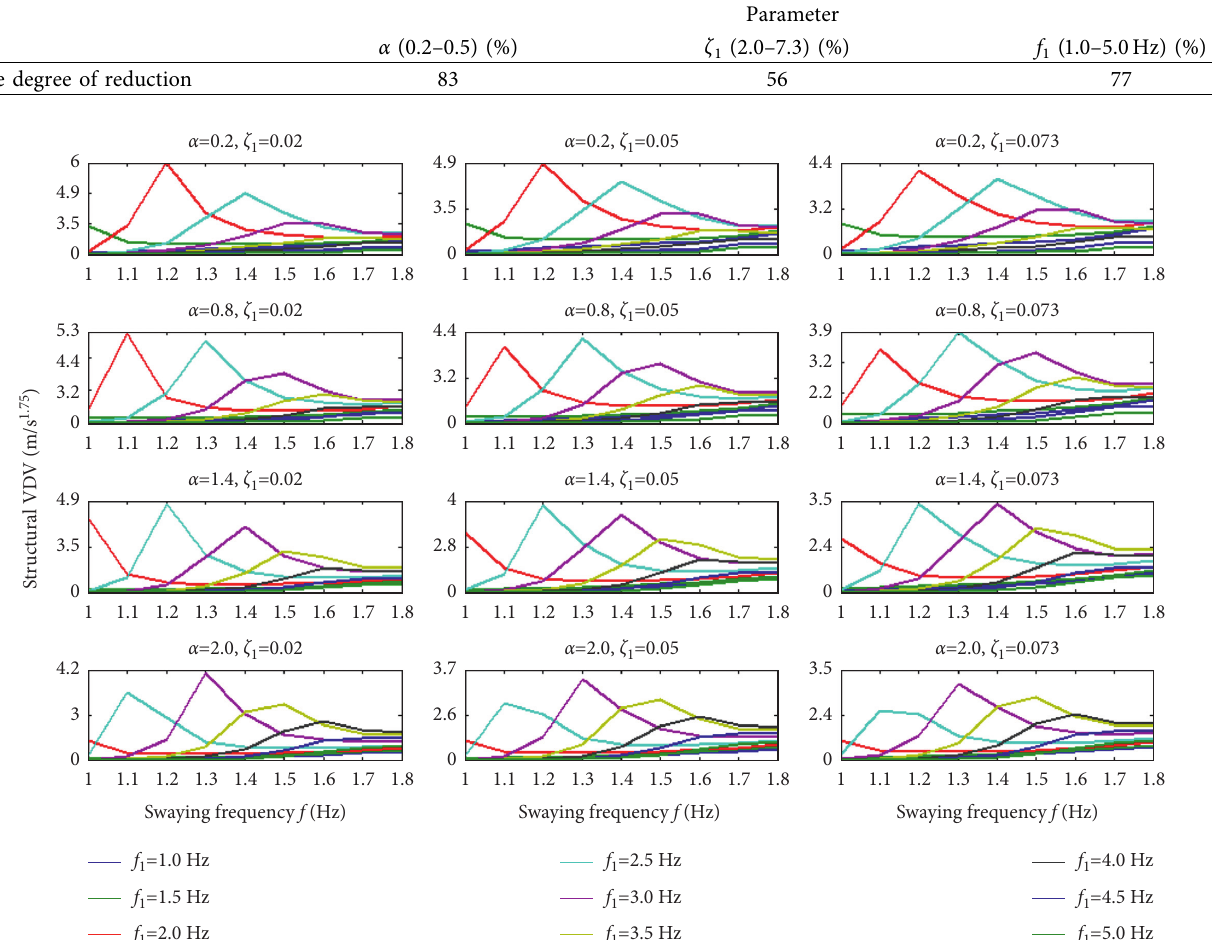
� 1.8Hz, f � 2.8 Hz of 2 3